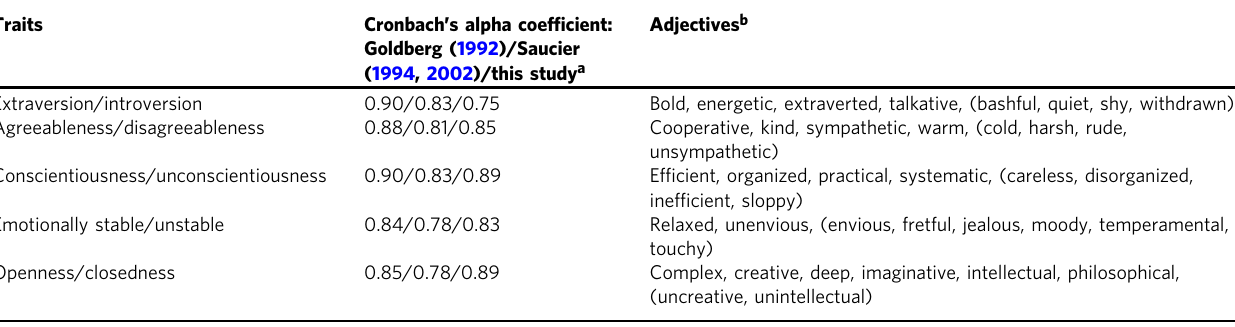
Table 1 Big-Five traits, Cronbach ’ s alpha coef fi cients for comparison, and Minimarker